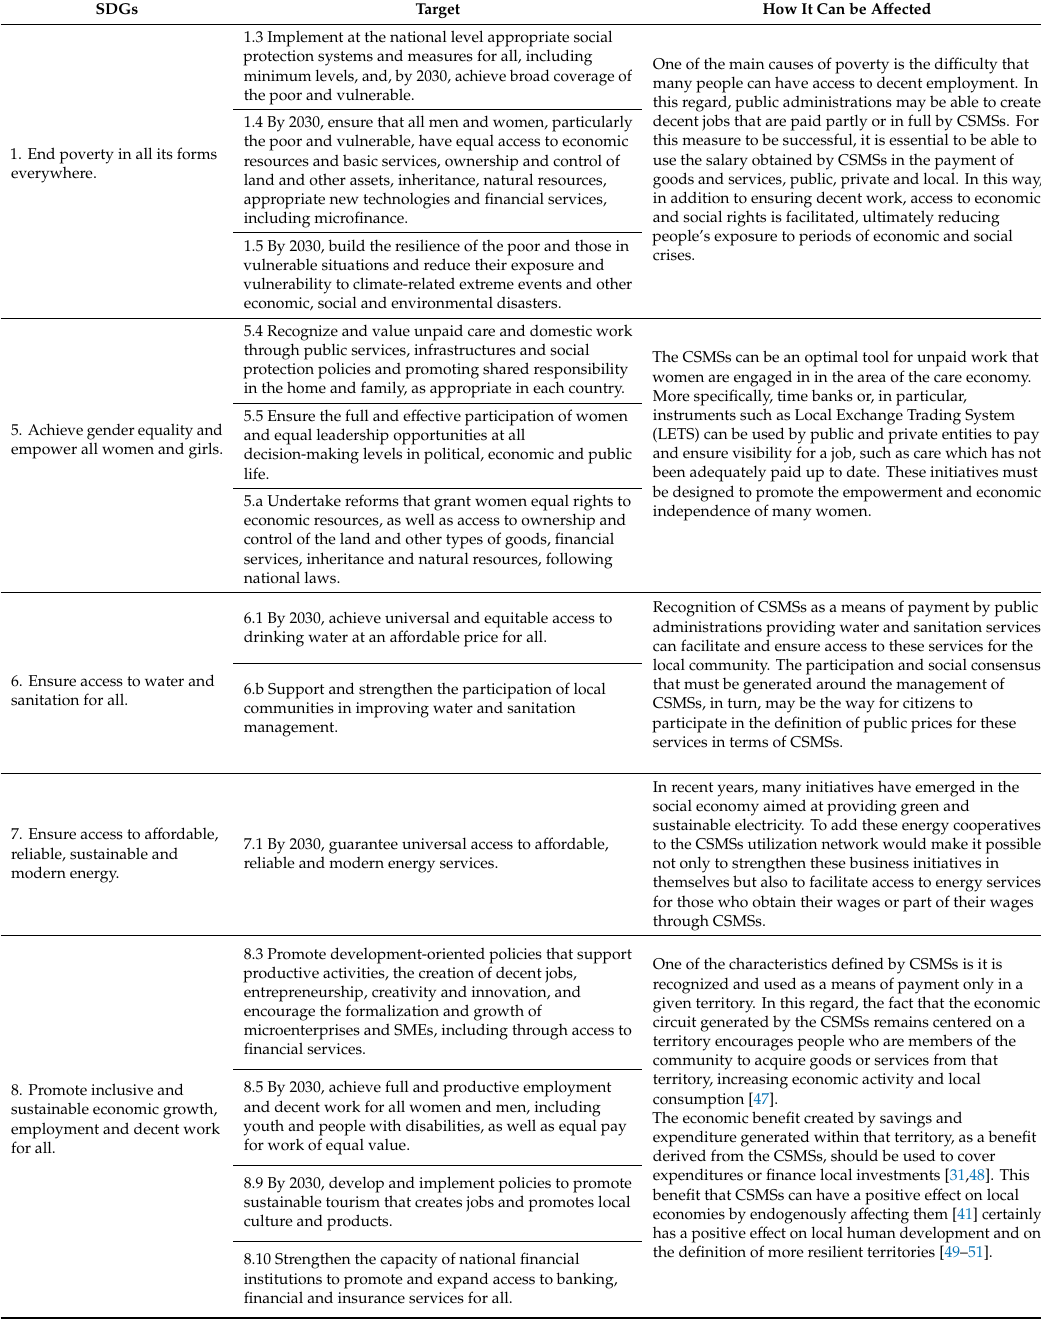
Table 1. Sustainable Development Goals and targets likely to be a ff ected by the implementation of a complementary social monetary system. SDGs Target How It Can be A ff